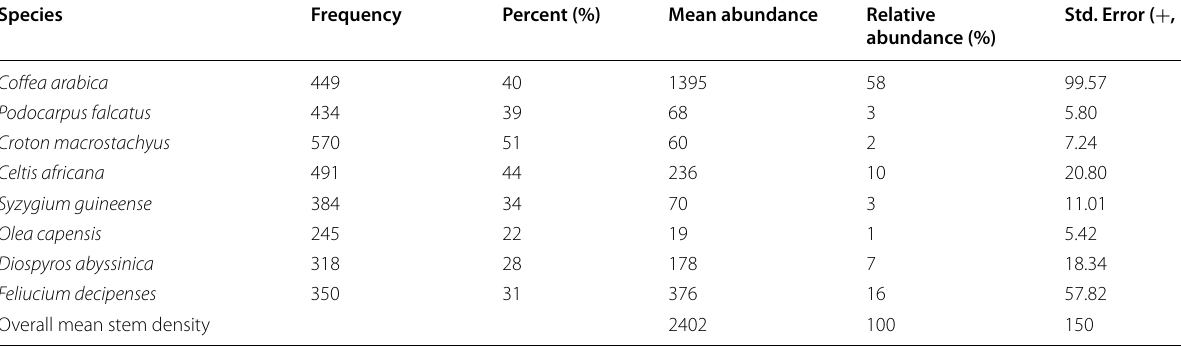
Table 1 Descriptive statistics of eight woody species in the Harana forest Species